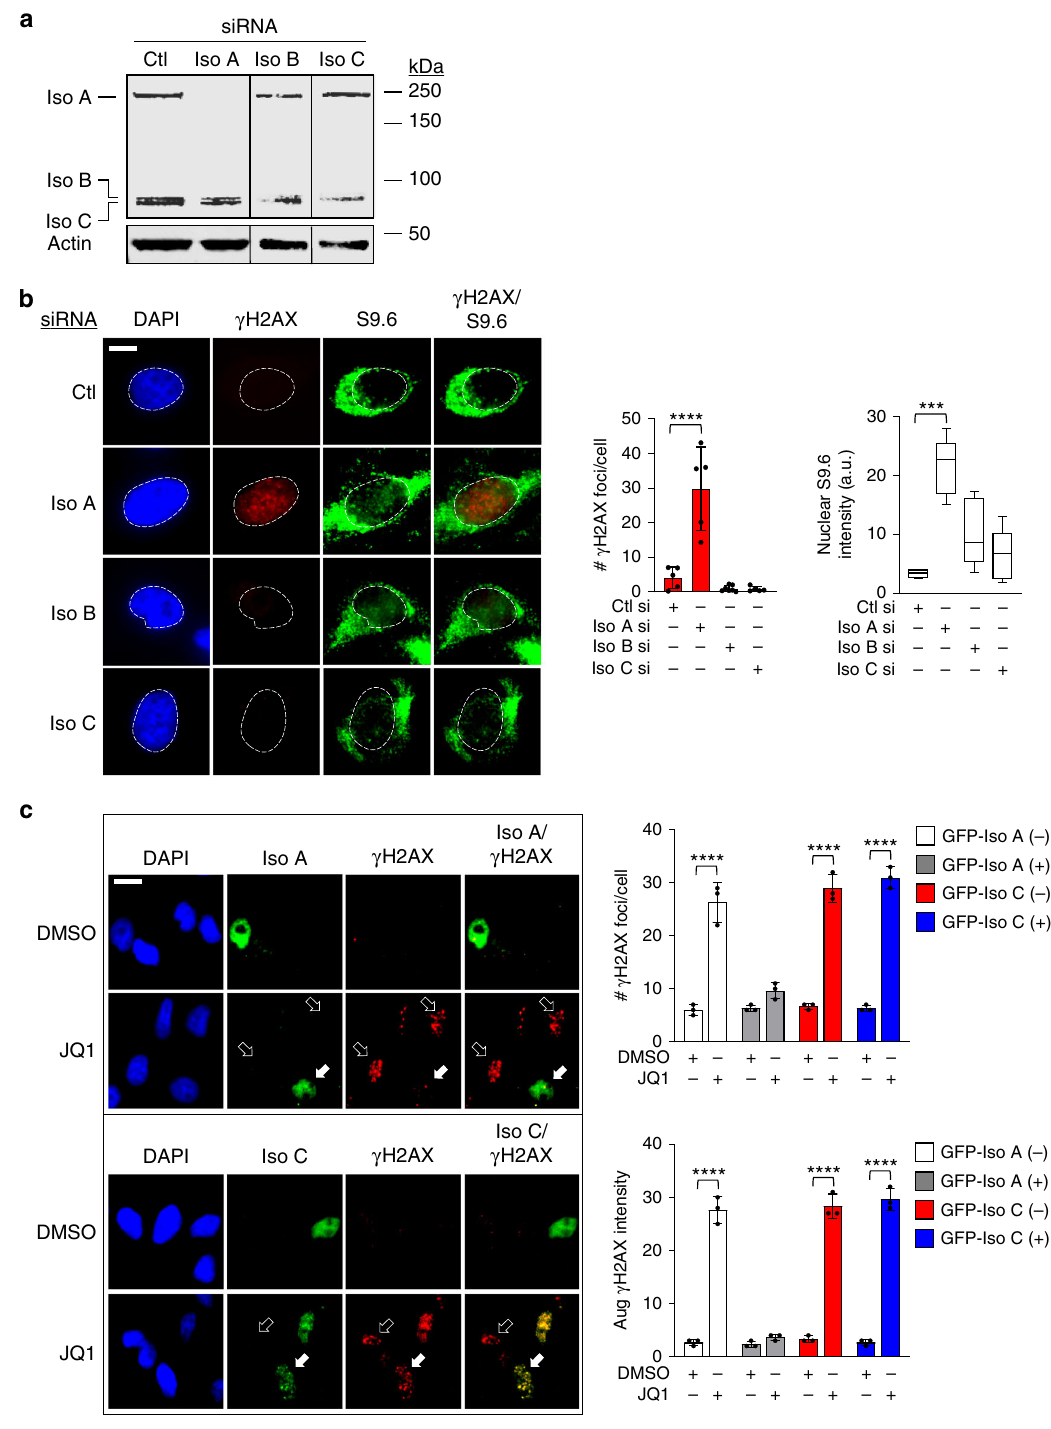
Fig. 5 BRD4 isoform A rescues R-loop-induced DNA damage. a WB of endogenous levels of BRD4 isoforms A, B, and C probed with a pan-BRD4 antibody following isoform-speci fi c siRNA knockdown. b Left panel: IF images of γ H2AX and S9.6 fl uorescence in HeLa cells following siRNA knockdown of BRD4 isoforms A, B, or C. Right panel: Quanti fi cation of γ H2AX foci and S9.6 nuclear intensities ( n = 3 separate experiments). γ H2AX foci are shown as mean ± SEM. Box-whisker plots for S9.6 intensity drawn as in Fig. 1b. Signi fi cance assessed using ANOVA followed by Tukey ’ s test ****Adjusted P < 0.0001. Scale bar = 2.5 μ m. c Left panel: IF images of γ H2AX fl uorescence in cells overexpressing GFP-tagged BRD4 isoforms (solid arrows) and in cells not overexpressing GFP-tagged BRD4 isoforms (open arrows) following JQ1 treatment. Right panel: quanti fi cation of γ H2AX foci and integrated nuclear intensity per cell ( n = 3 separate experiments) presented as mean ± SEM. Signi fi cance assessed using two-tailed unpaired t test for γ H2AX foci per cell, **** P < 0.0001. Scale bar in b , c = 5 μ m. Source data are provided as a Source data fi